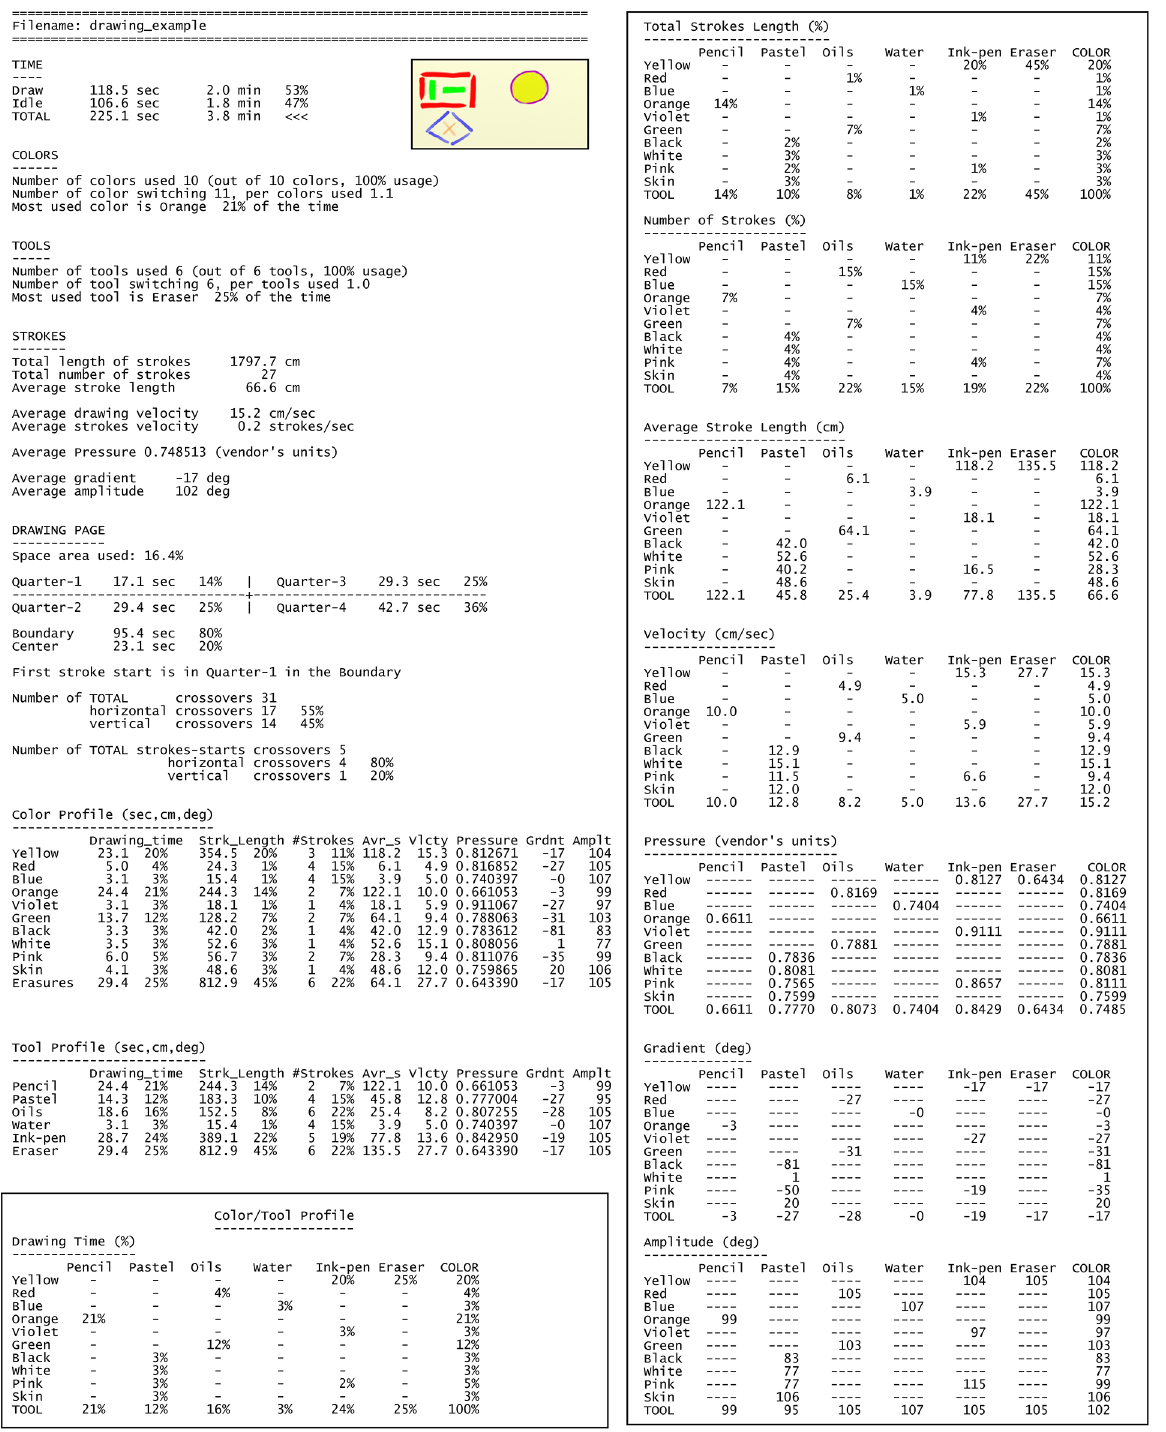
Fig 7. Quantification of the artwork construction dynamics. The textual report of an art creation process dynamics. It shows the quantitative tracking and analysis of an artwork ’ s creation specified by the parameters' table of Fig 5 and their cross-section calculations (the respective visual report of the creation dynamics is shown in Fig